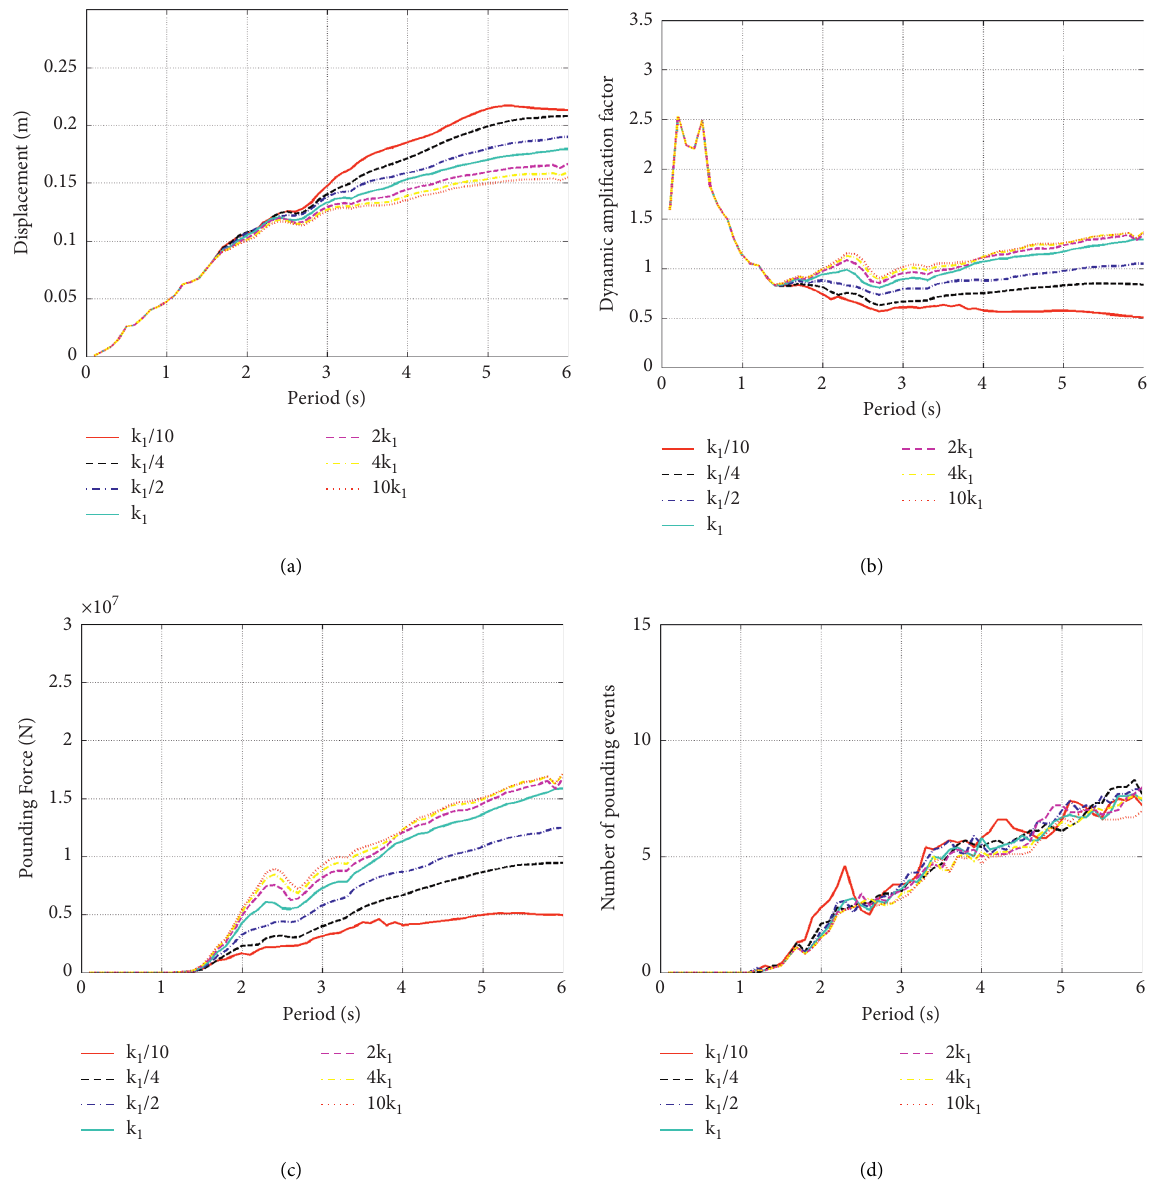
Figure 11: Average spectral analysis results with different stiffnesses of abutment. (a) Displacement spectrum. (b) Dynamic amplification factor spectrum. (c) Pounding force spectrum. (d) Number of pounding event response